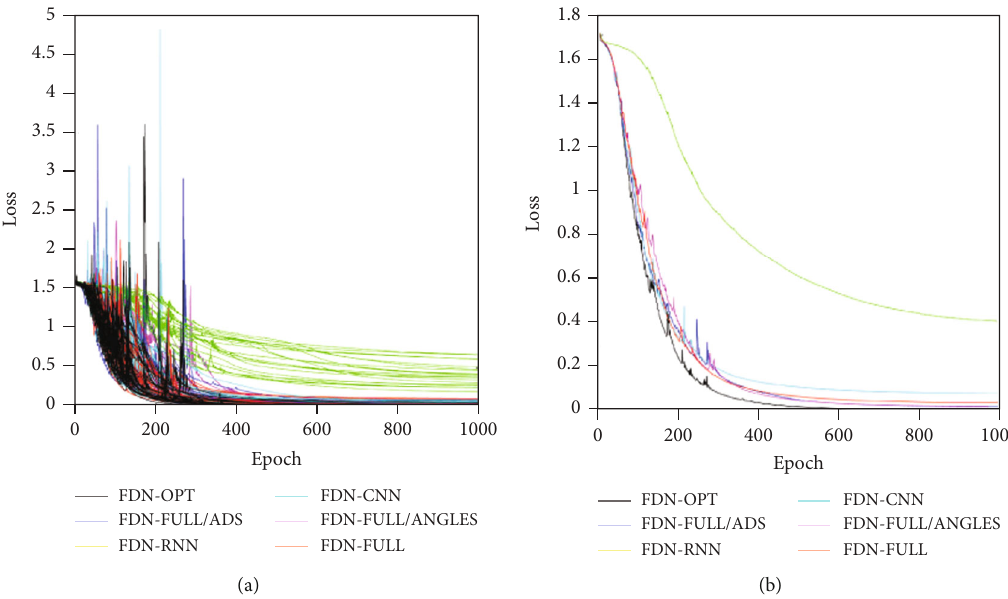
Figure 8: FDN training history: (a) training history of di ff erent architectures (20 times of training for each architecture); (b) average loss of each architecture in 20 times of training.